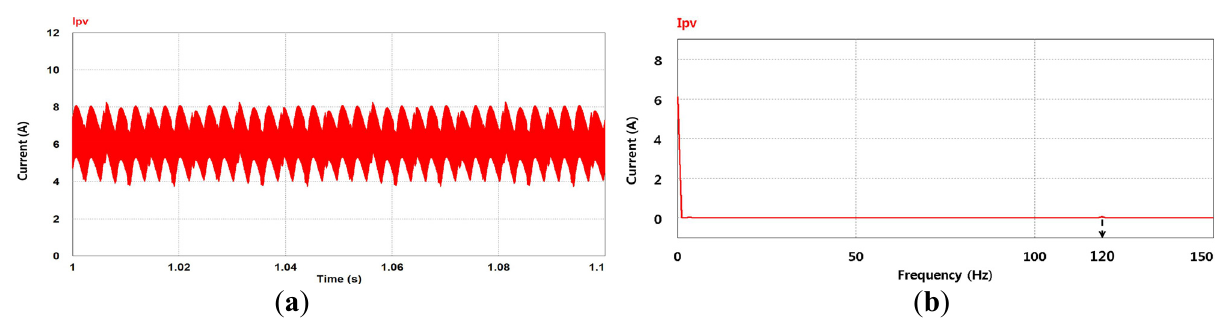
Figure 16. Simulation waveform of PV current with compensation. ( a ) Time domain; ( b ) frequency